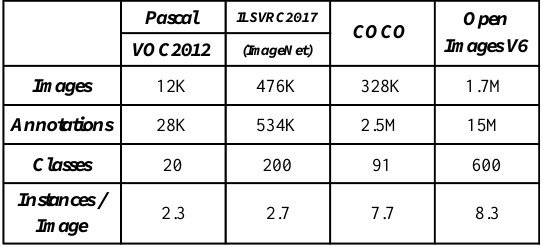
Table 1. Comparison between common OD